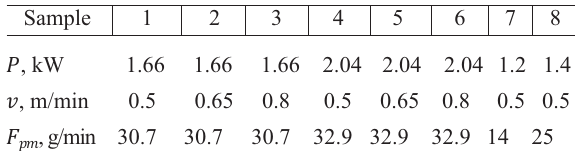
Table 3. Technological parameters of the laser cladding experiment